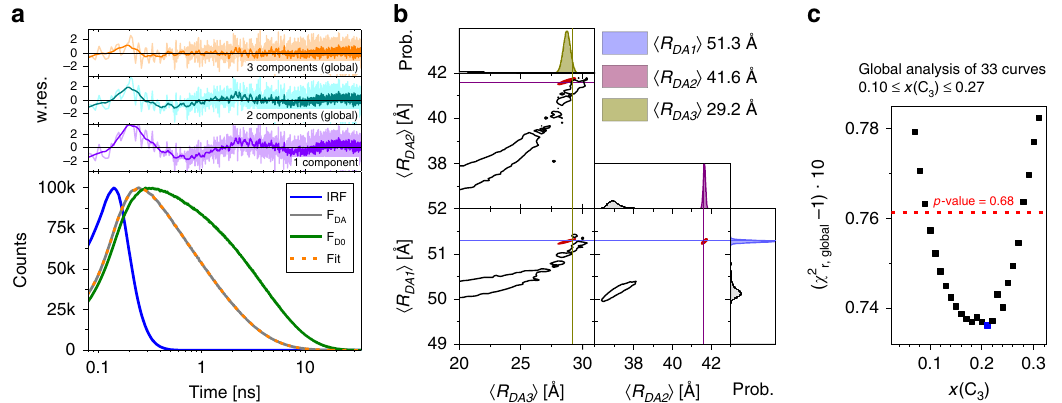
Fig. 4 Uncovering the third conformational state by eTCSPC. The eTCSPC measurements of all FRET variants are analyzed by superposition of normal distributed DA-distances (due to the coupling of dyes with long and fl exible linkers, details see Supplementary Methods). a Experimental fl uorescence decay of the variant S36pAcF/P86C ( F DA , gray, over laid in orange with best fi t), the corresponding DOnly-reference sample ( F D0 , green), and instrumental response function (IRF, blue). At the top, the weighted residuals (w.res.) of different analyses by models with DA-distance distributions composed of one (violet), two (cyan), and three (orange) normal distributions are shown in corresponding colors. In the 2- and 3-component analysis, all FRET- measurements are jointly analyzed (global), and the species fractions of the states are shared among all 33 datasets. For the 1-component model of the variant S36pAcF/P86C, we fi nd a mean DA-distance of 45.7 Å with a width of 17.6 Å. The analysis results of the 3-component model are summarized in Supplementary Table 2d – g. b Uncertainties, Δ R DA ( k FRET ), of the 3-component analysis for the variant S36pAcF/P86C. Other contributions to the total uncertainty, Δ R DA , i.e. κ 2 , are not shown for clarity. To the sides, the marginalized (projected) histograms of the sampled model parameters are shown (black: individual fi t; red: global fractions). The lines highlight the most likely combination of distances. c Uncertainty estimation of the species fraction of the third (minor) state, x (C 3 ), for the three-component analysis. The fraction x (C 3 ) was varied from 0 – 0.32 followed by a subsequent minimization of all other model parameters. This yields the global, reduced χ 2 r,global of all 33 FRET eTCPSC measurements in dependence of x (C 3 ). This curve has a minimum at x (C 3 ) = 0.21 ( χ 2 r,min = 1.074). Points above the red line ( χ 2 r = 1.0761, p -value = 0.68) are signi fi cantly worse than the best analysis result as judged by an F -test (225 parameters, 100,000